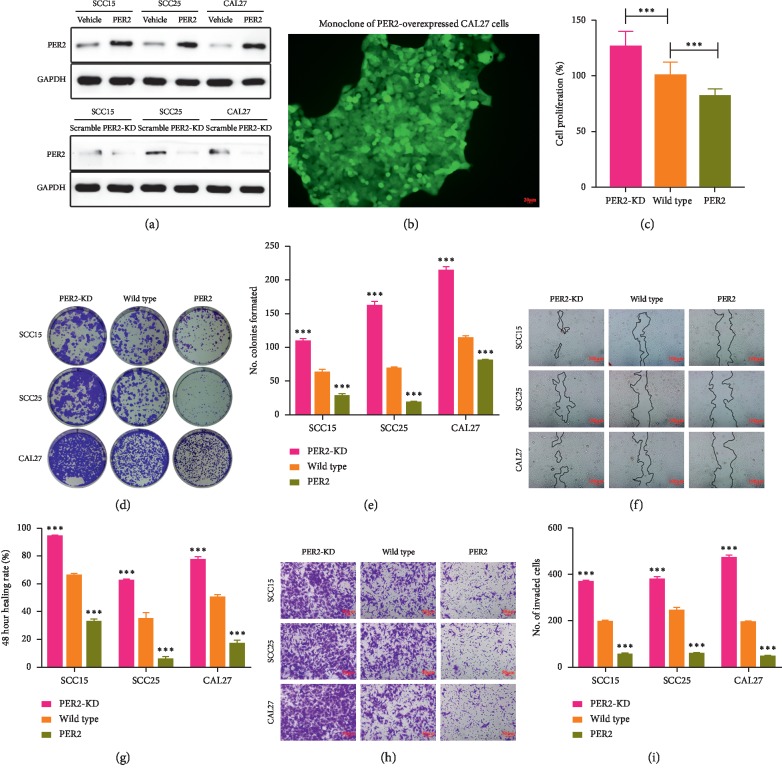
PER2 inhibits OSCC cell proliferation, migration, and invasion in vitro. (a) Western blotting analysis of PER2 expression. (b) The monoclone of PER2-overexpressed CAL27 cells. (c) PER2 inhibited cell proliferation of CAL27 cells. (d and e) Growth of OSCC cells was detected using the clone formation assay. (f and g) Representative microphotographs of wound-healing assays. Black lines mark the migration front. (h and i) Representative microphotographs of invasion assays.